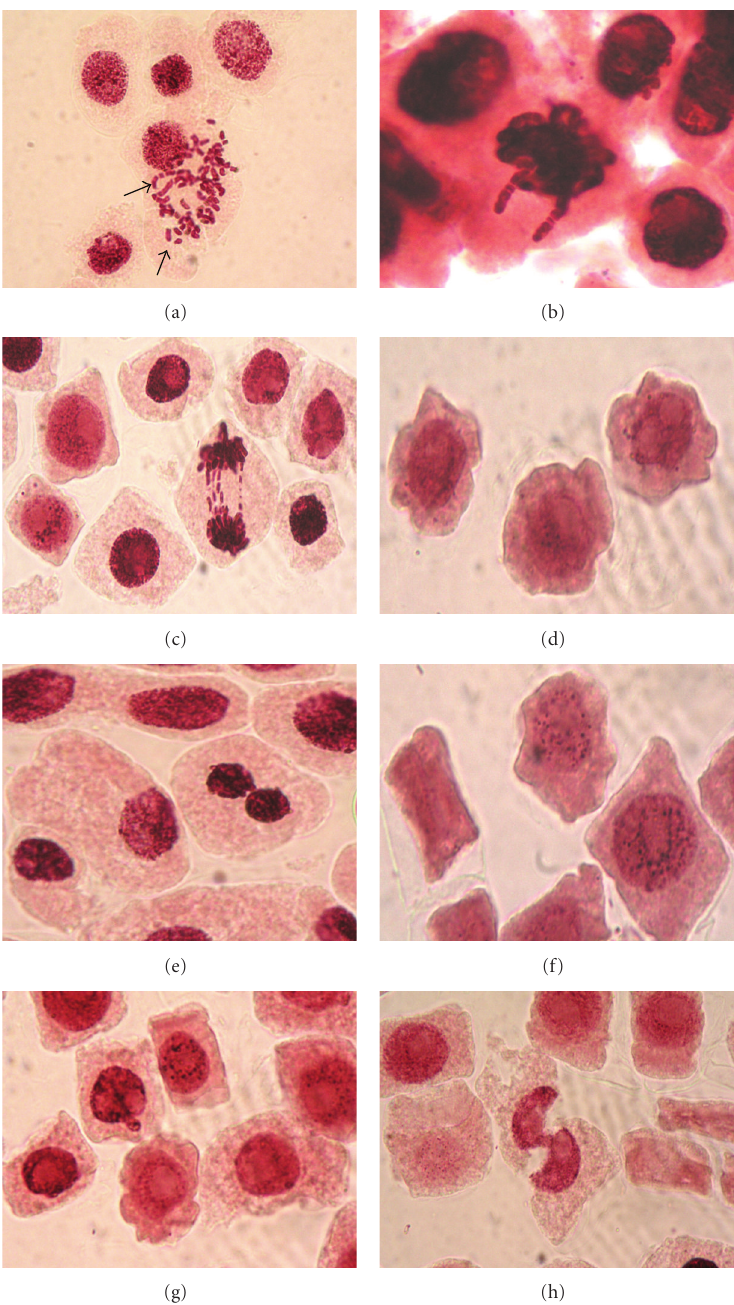
Figure 1: Mitotic and chromosomal aberrations after the Inula viscosa leaf extract treatments in Allium cepa root tip meristem cells visualized with light microscopy. (a) Fragments; (b) stickiness; (c) polar deviation and chromatid bridges; (d) membrane damage; (e) binucleated cell; (f) apoptotic bodies; (g and h) cells with damaged